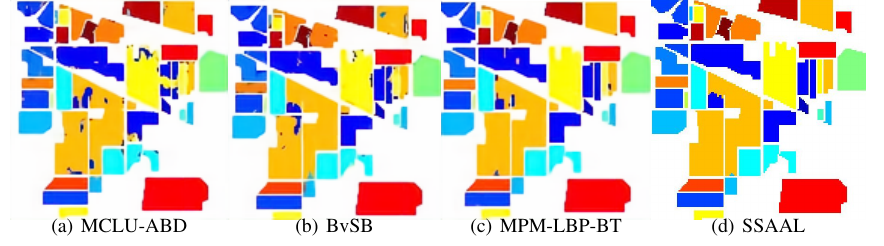
Figure 6. Classification maps obtained by different AL techniques on the Indian Pines dataset.